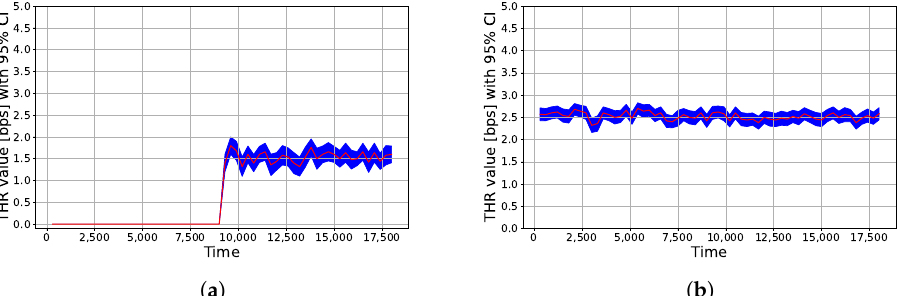
Figure 12. “Instantaneous” throughput values yielded by UWHMMPhysical module from node 1 to node 3 ( a ) and from node 4 to node 2 ( b ).